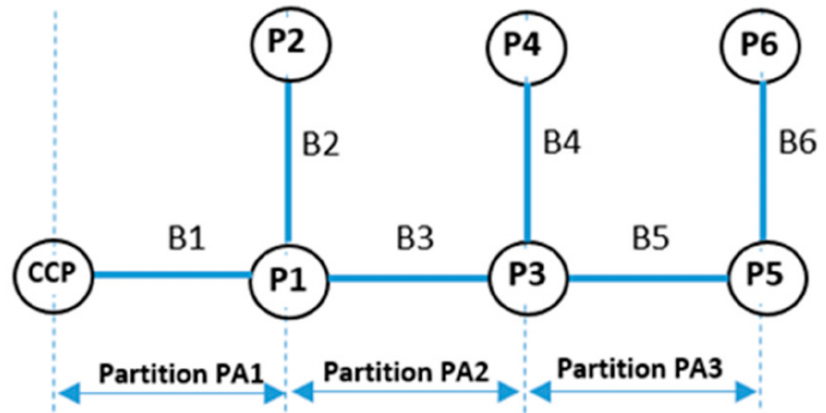
Figure 5. An AEDN with seven poles (including CCP) and six